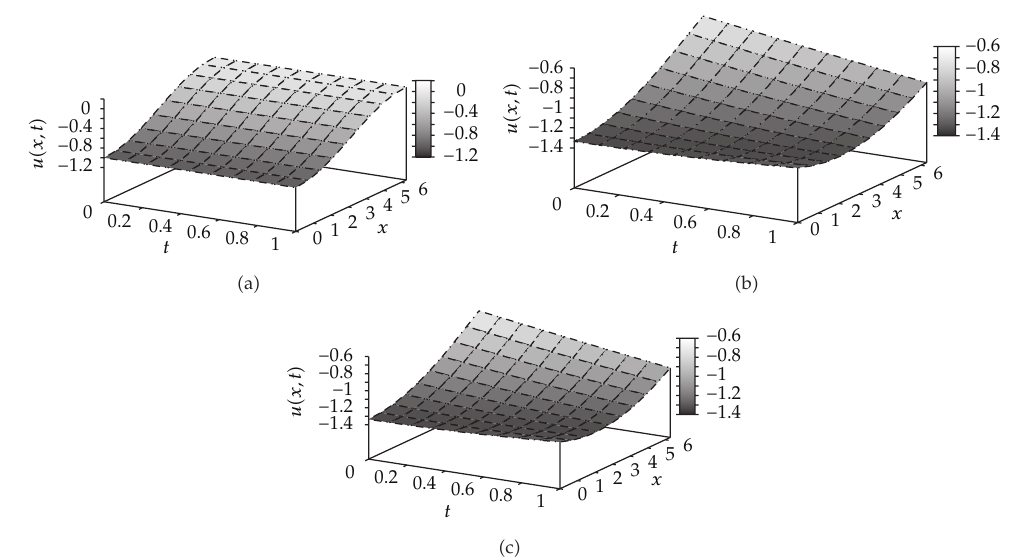
Figure 1: The approximate solution of fractional Rosenau-Hynam equation when α (cid:8) 1 . 0 and c (cid:8) 0 . 5